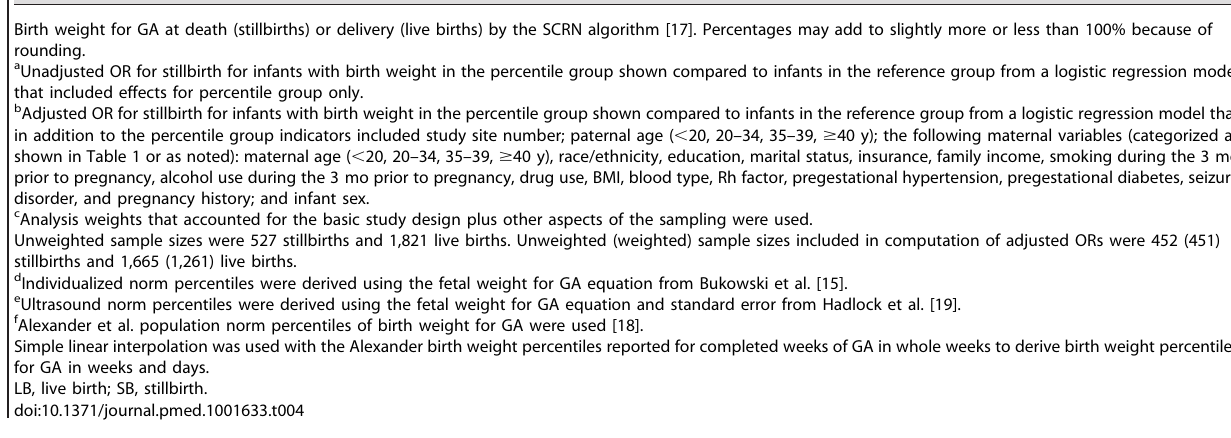
Birth Weight Norms and Percentiles SB LB Crude OR for SB (95% CI)